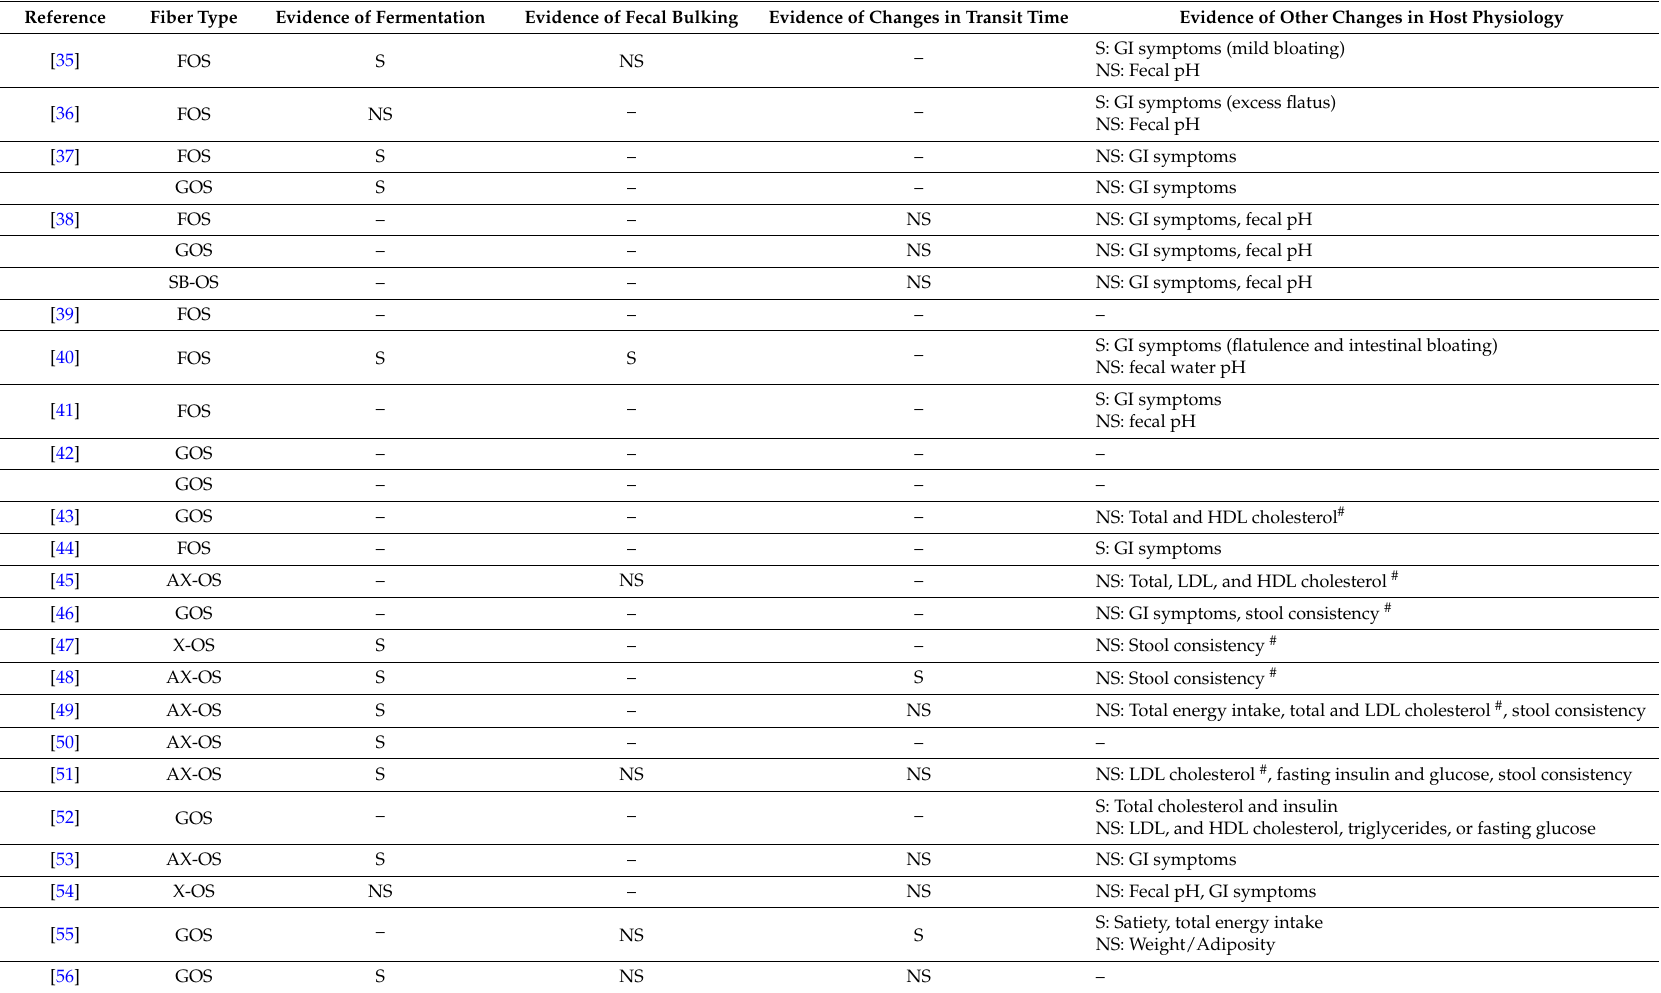
Abbreviations: AX-OS, arabinoxylan-oligosaccharides; FOS, fructooligosaccharides; GOS, galactooligosaccharides; NS, no statistically significant health benefit was observed; S, a significant effect was observed; SB-OS, soybean oligosaccharides; X-OS, xylo-oligosaccharides; # No significant effect of intervention, but the effect was in a direction opposite to providing a health